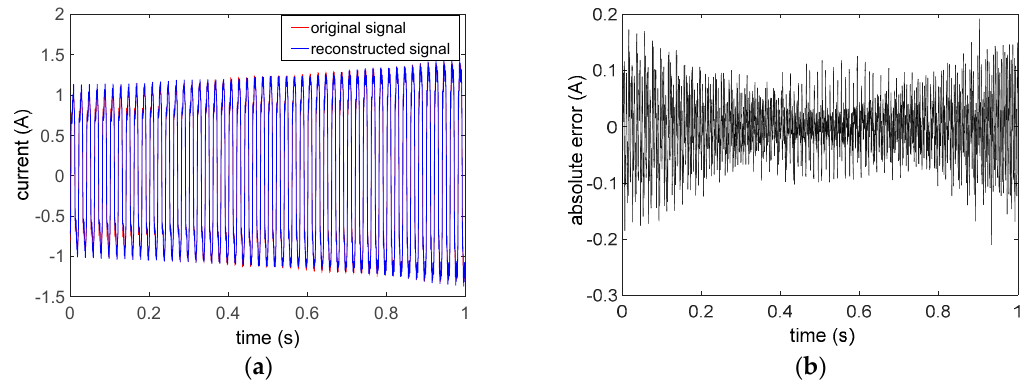
Figure 7. Analysis results of envelope current signal of an electric locomotive when employing the improved method based on WIFFT and DE: ( a ) Comparison of the original signal and reconstructed signal; ( b ) Absolute error of original signal and reconstructed signal.